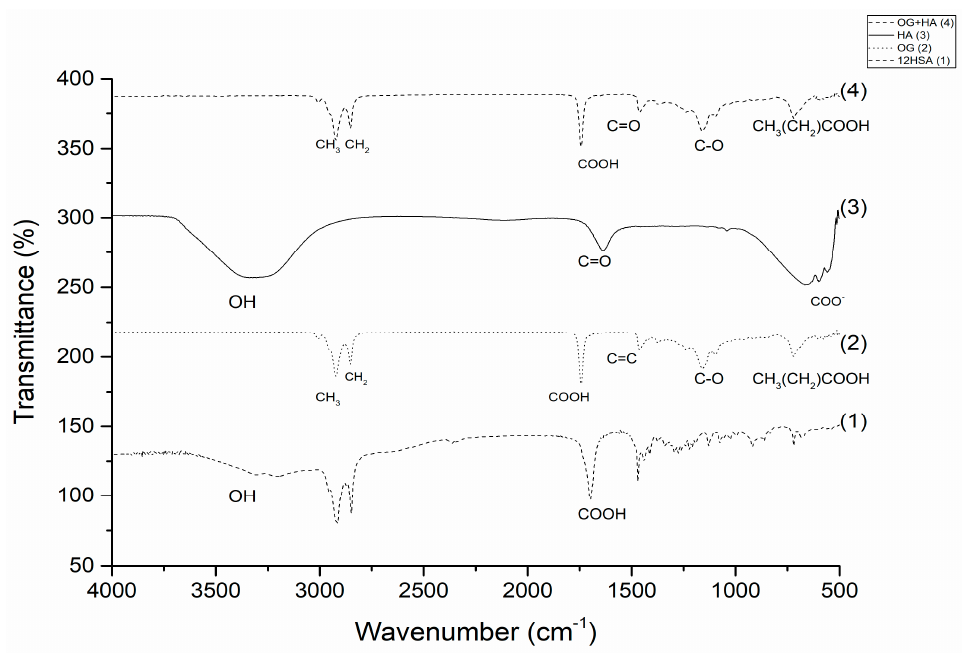
Figure 1. FTIR spectrum of 12HSA, OG, AH, and OG + HA submitted to a resolution of 2 cm − 1 and a range of 4000 to 400 cm − 1 .